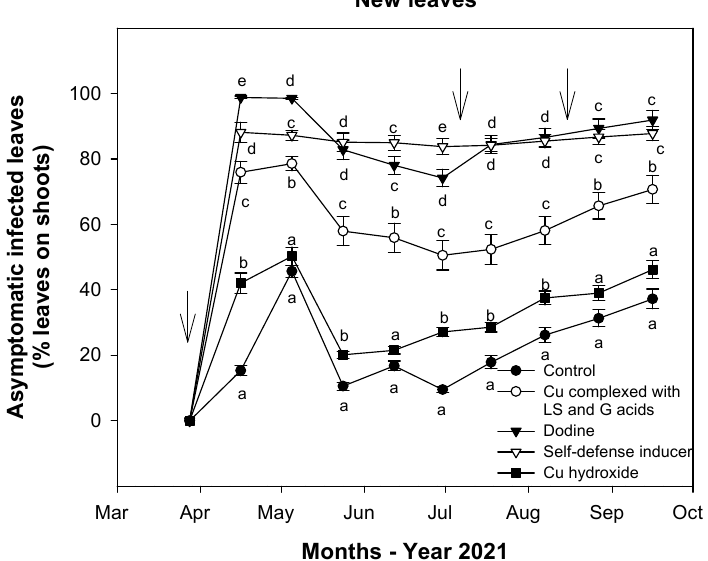
Figure 5. Effect of chemical treatments on asymptomatic Venturia oleaginea infection in new leaves (grown in 2021). The arrows indicate the dates of fungicide application. The bars represent the standard error. For each date, means followed by different are significantly different at p ≤ 0.05.